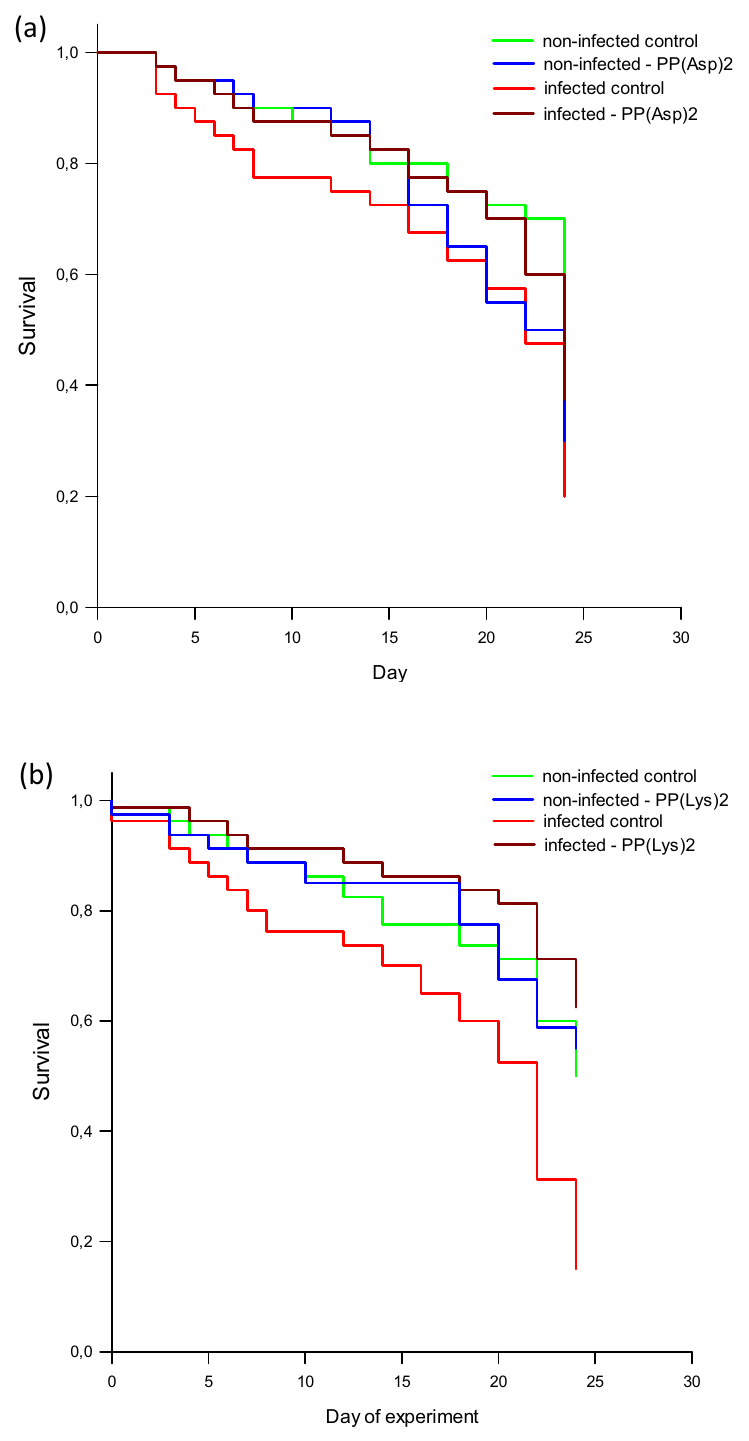
Figure 3. Kaplan–Meier survival curves for uninfected and N. ceranae- infected honeybees treated with protoporphyrin IX derivatives ( a ) PP(Asp) 2 and ( b ) PP(Lys) 2 administered with the sucrose syrup